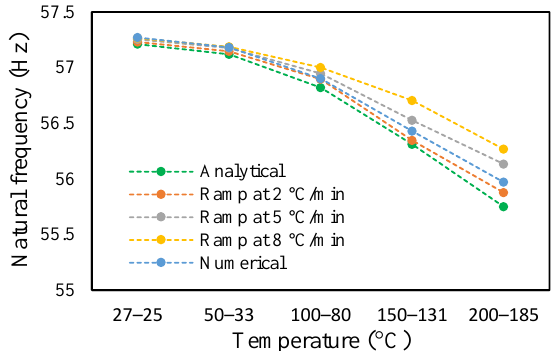
Figure 13. Natural frequency of 0.5 mm crack depth in non-uniform temperature.